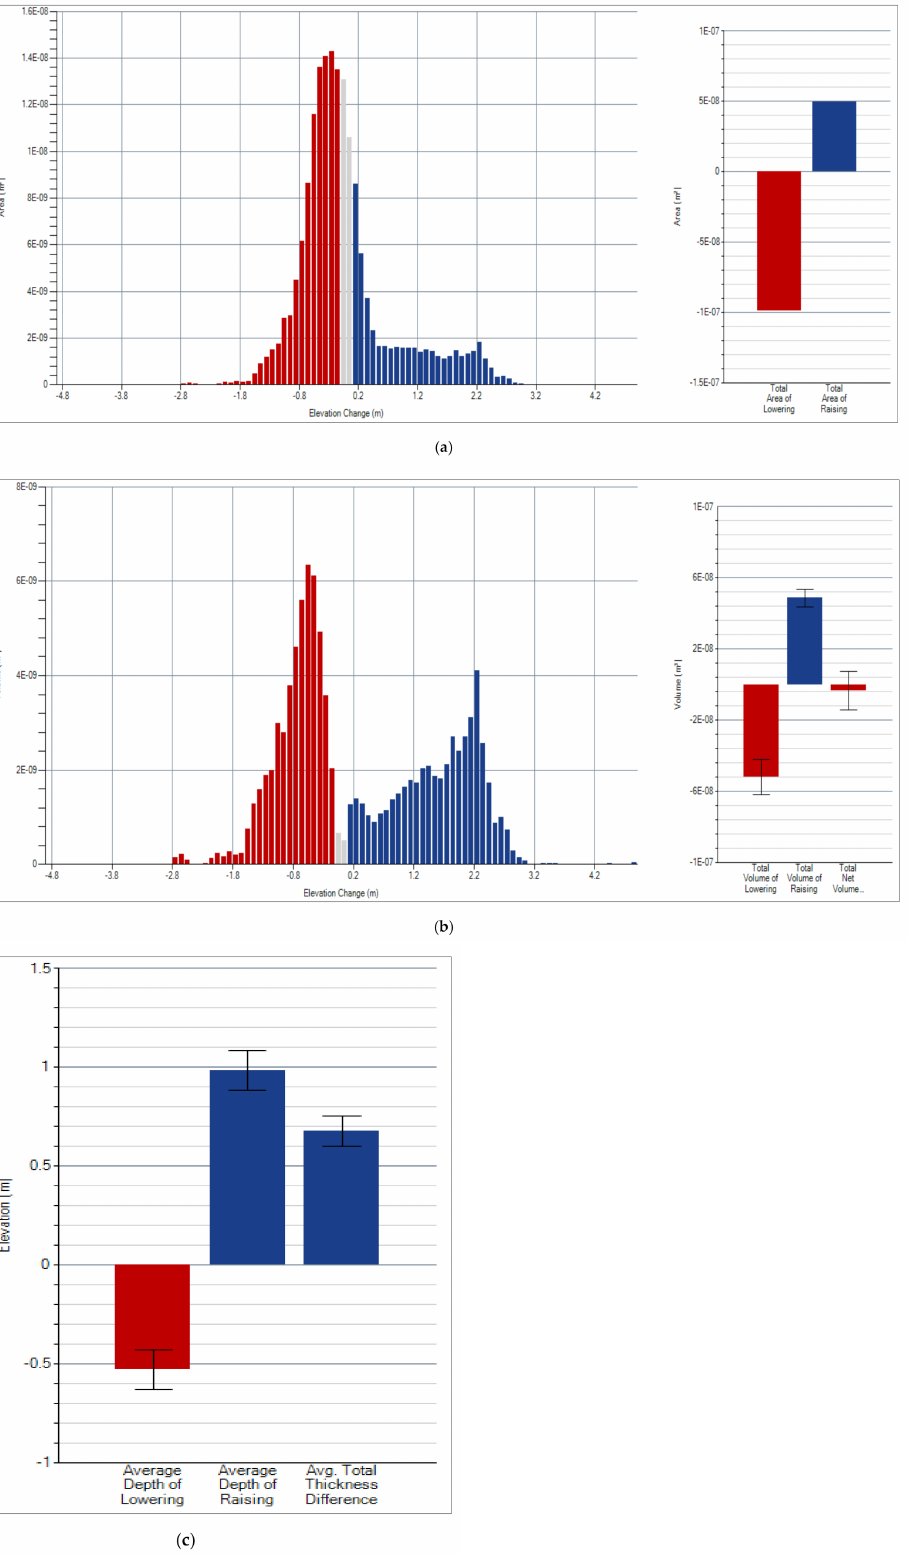
Figure A3. GCD result for ROI